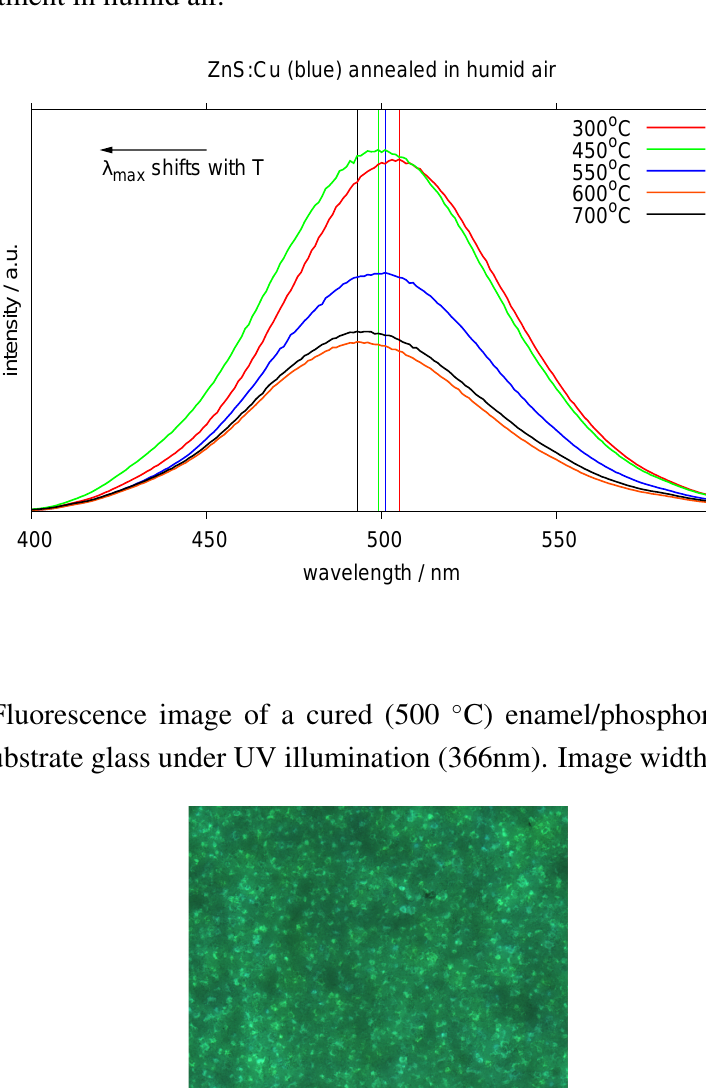
Figure 9 . Spectral shift and reduction of emission intensity of AC-EL (ZnS:Cu) phosphor after heat treatment in humid air.